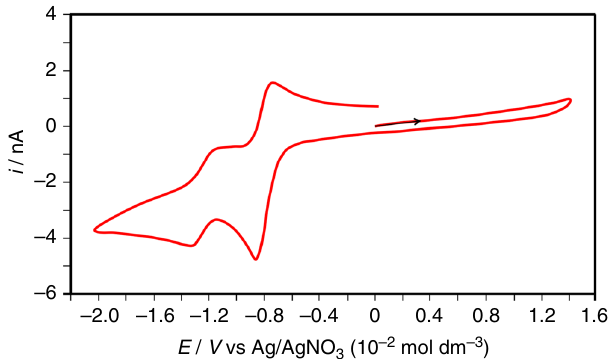
(Fig. 2) and con fi rmed by bond – valence sums 42 (Supplementary Table 1). There is one terephthalate strut on a general position